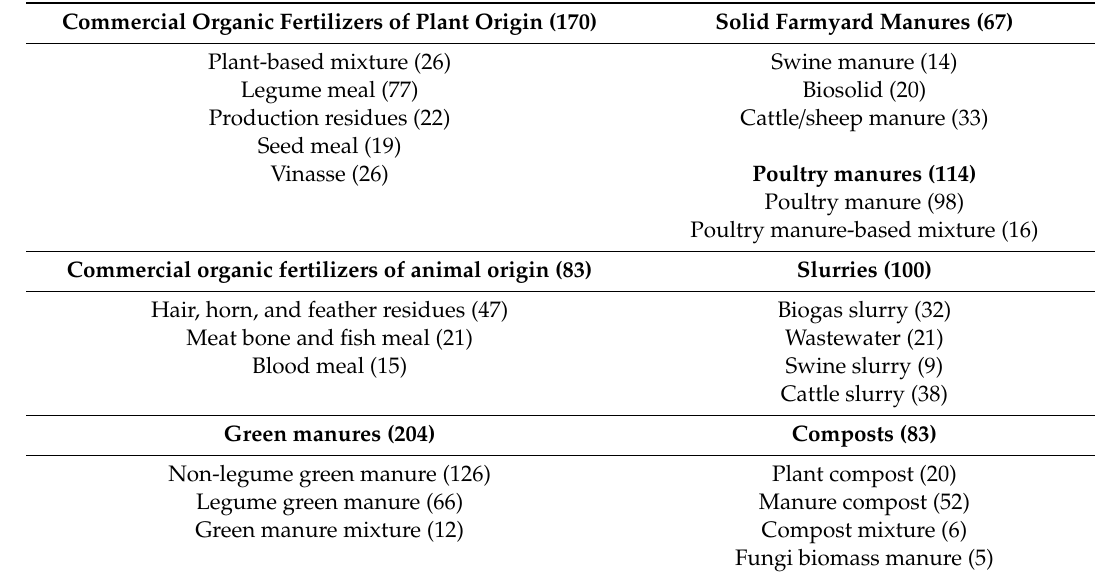
Table 1. Overview of the main groups (bold text) and corresponding subgroups. The numbers in parentheses represent the number of